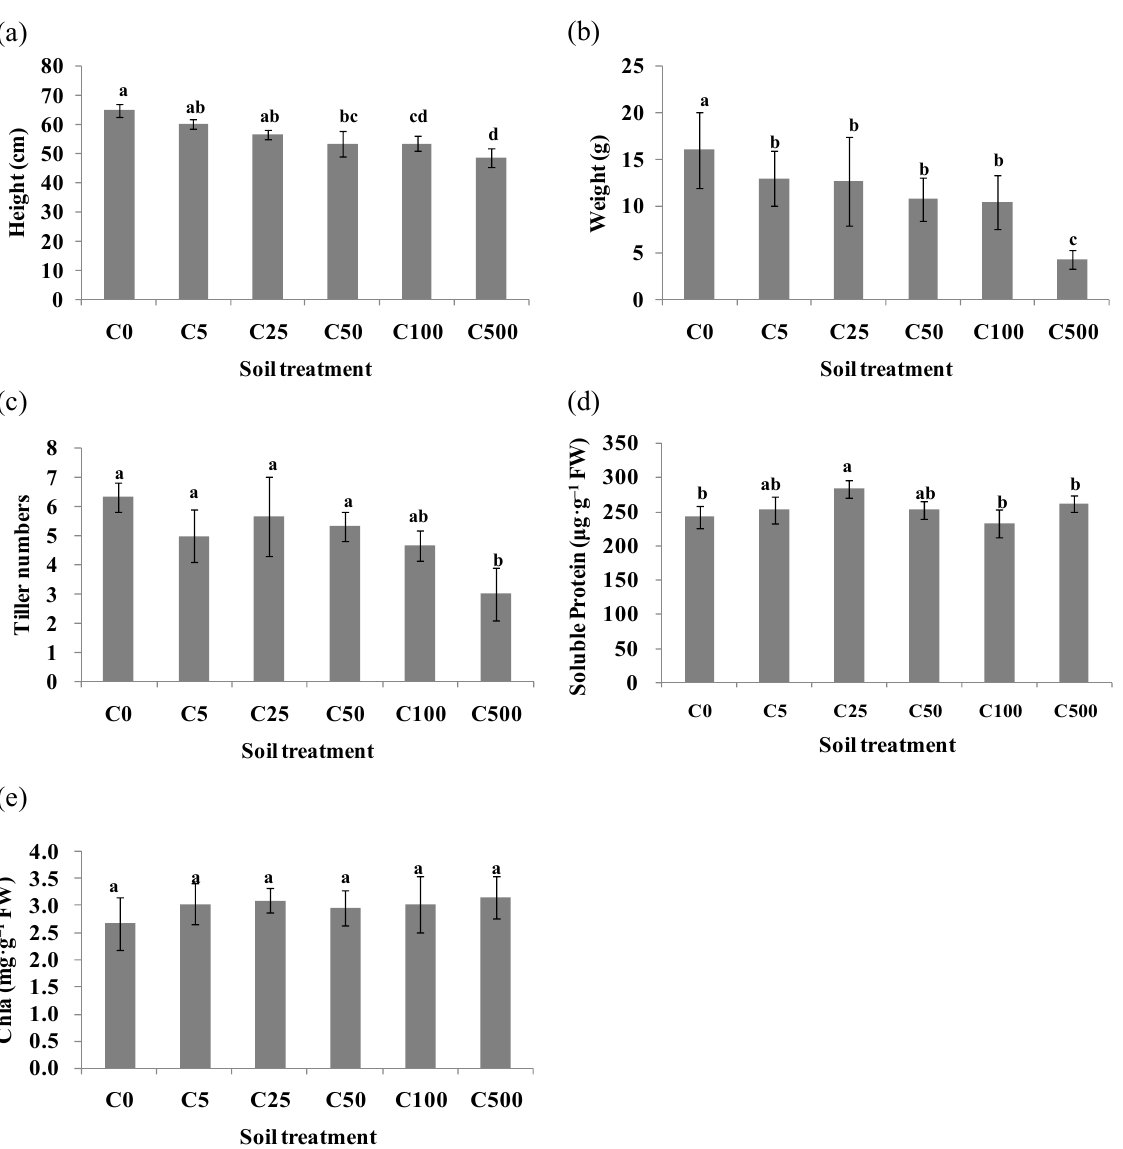
Figure 1. The growth physiological analysis of ryegrass under Cd stress for ( a ) height, ( b ) weight, ( c ) tiller number, ( d ) soluble protein and ( e ) chla content. Values are expressed as means of three replicates with standard deviations (±SD). Different lowercase letters indicate that values are significantly different at P < 0.05.